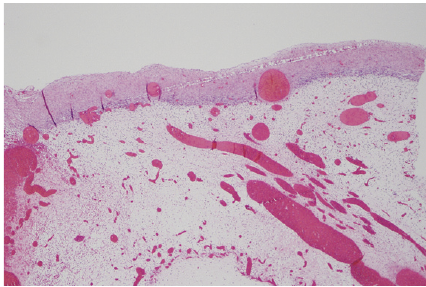
Figure 3: Medium power view of thrombosed vessels with extensive interstitial hemorrhage.